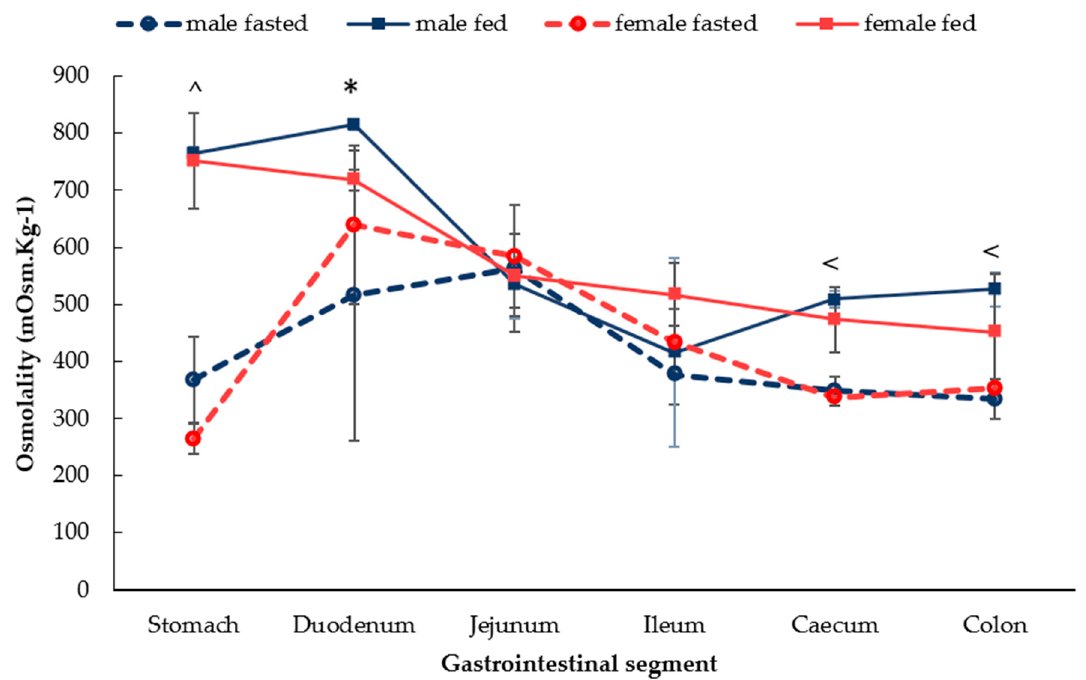
Figure 3. Osmolality of the GI fluids in male and female in the fasted state and fed state rats. (Mean ± SD, n = 6). The following symbols (i) < denotes a statistical significance ( p < 0.05) between fasted and fed state in male rats, (ii) ˆ denotes a statistical significance ( p < 0.05) between fasted and fed state in both male and female rats and (iii) * denotes a statistical significance ( p < 0.05) between males and females.